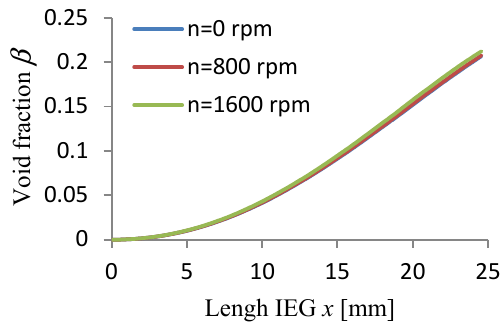
Figure 12. Void fraction distribution β .